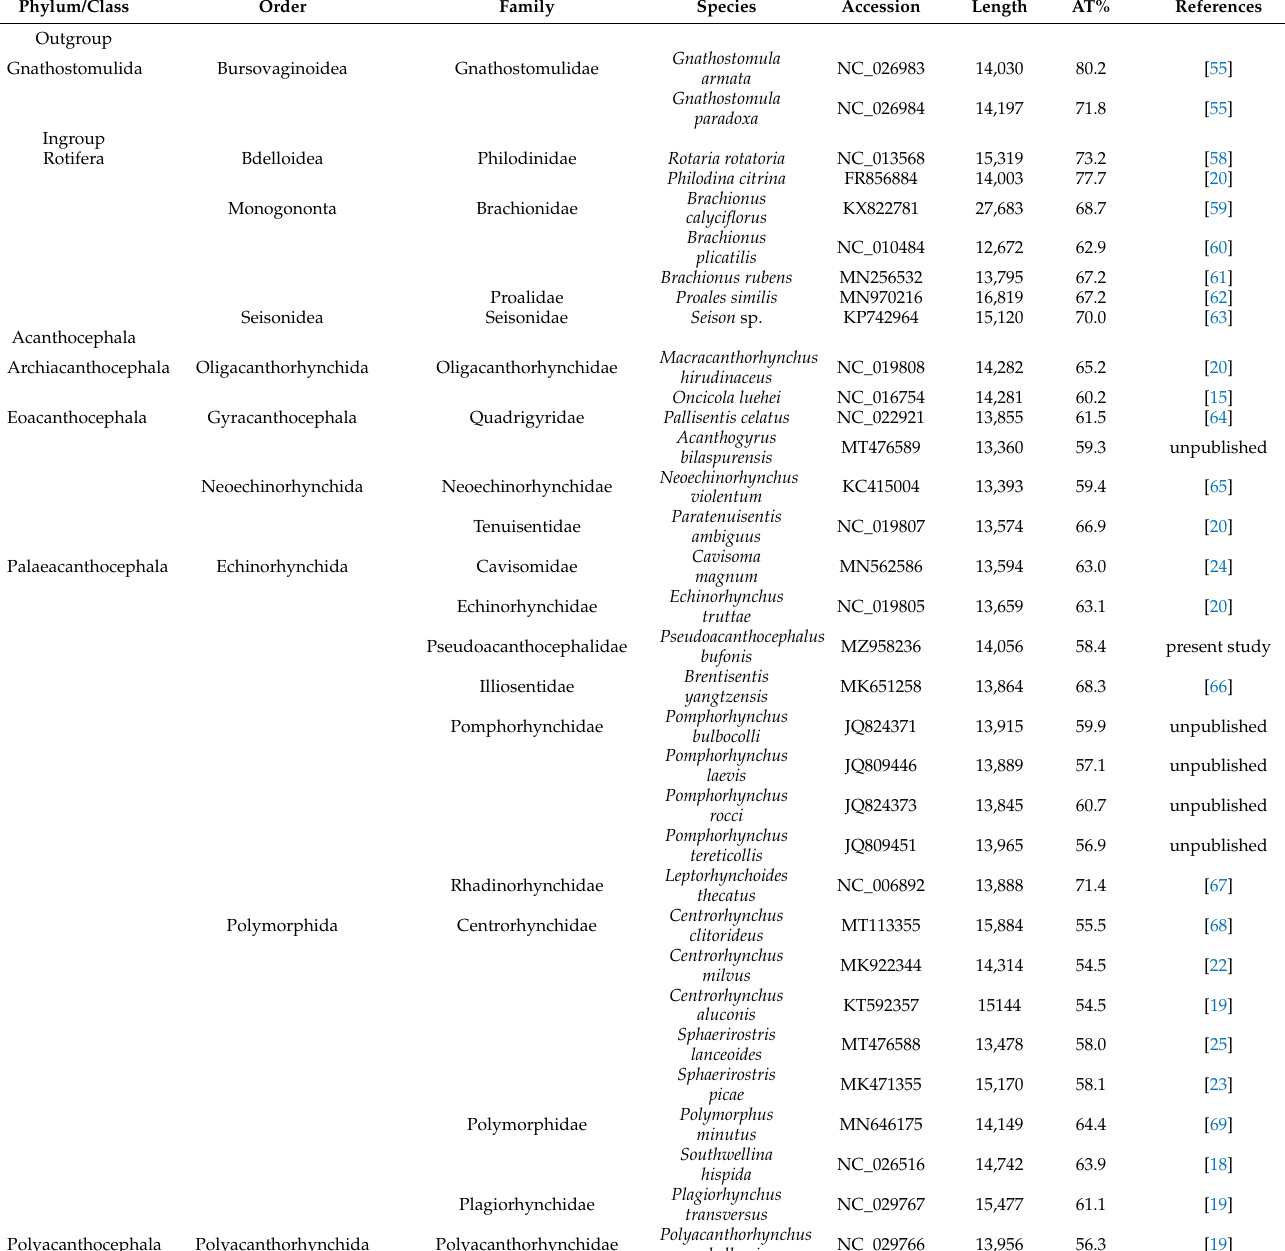
Table 1. Detailed information on representatives included in the present